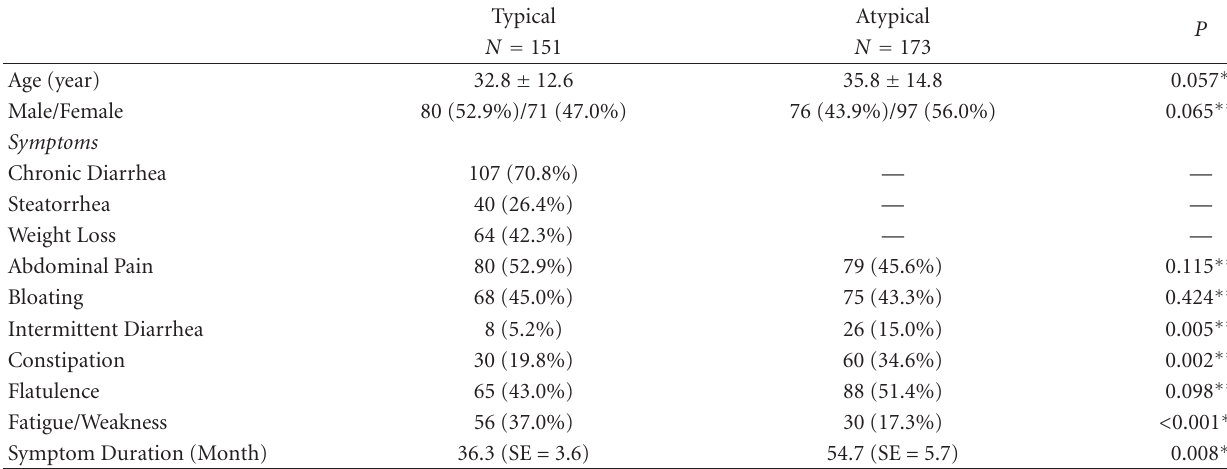
Table 1: Patients’ characteristics.